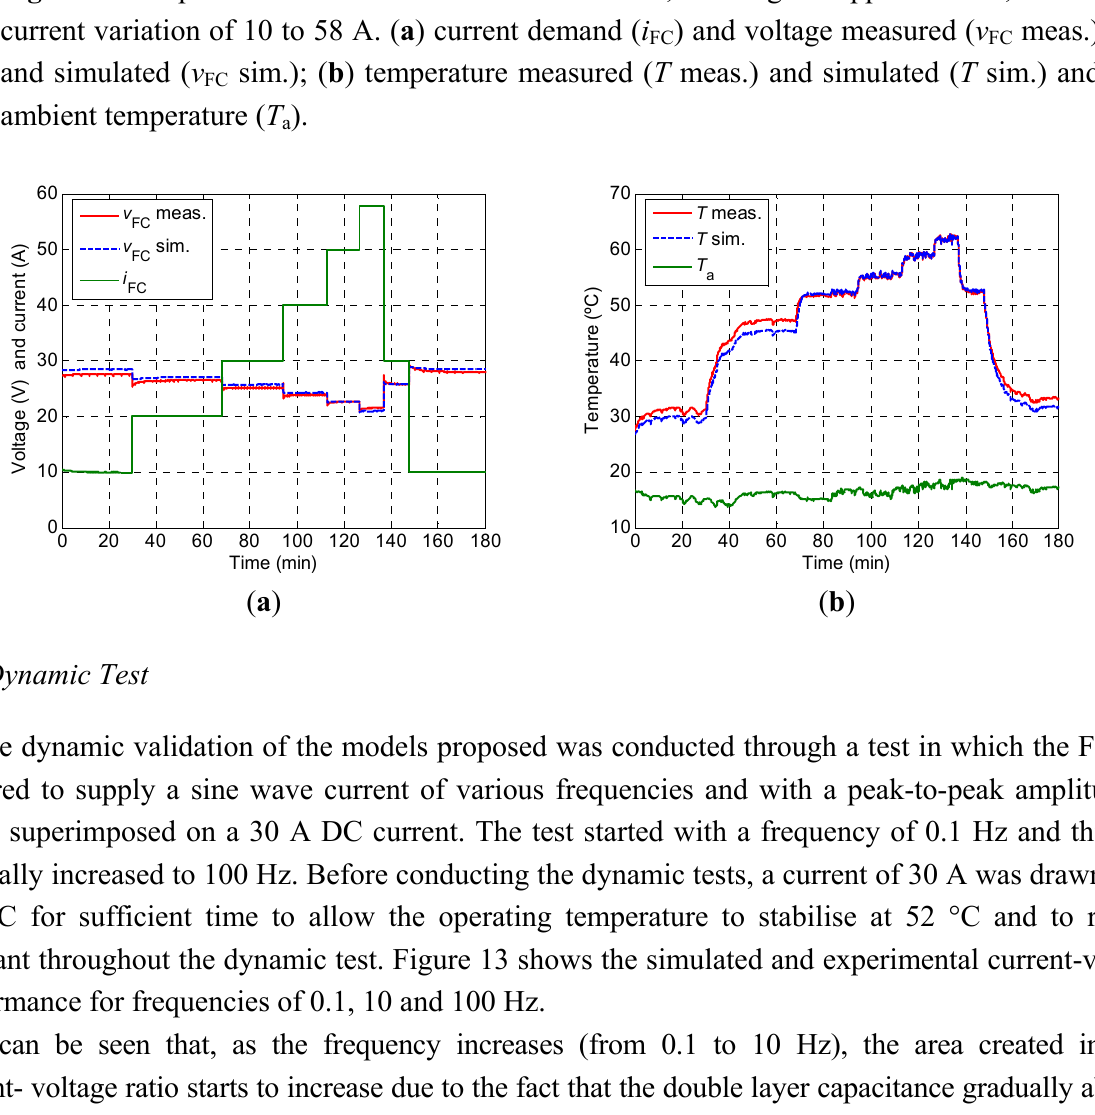
) and voltage measured ( v meas.) FC FC